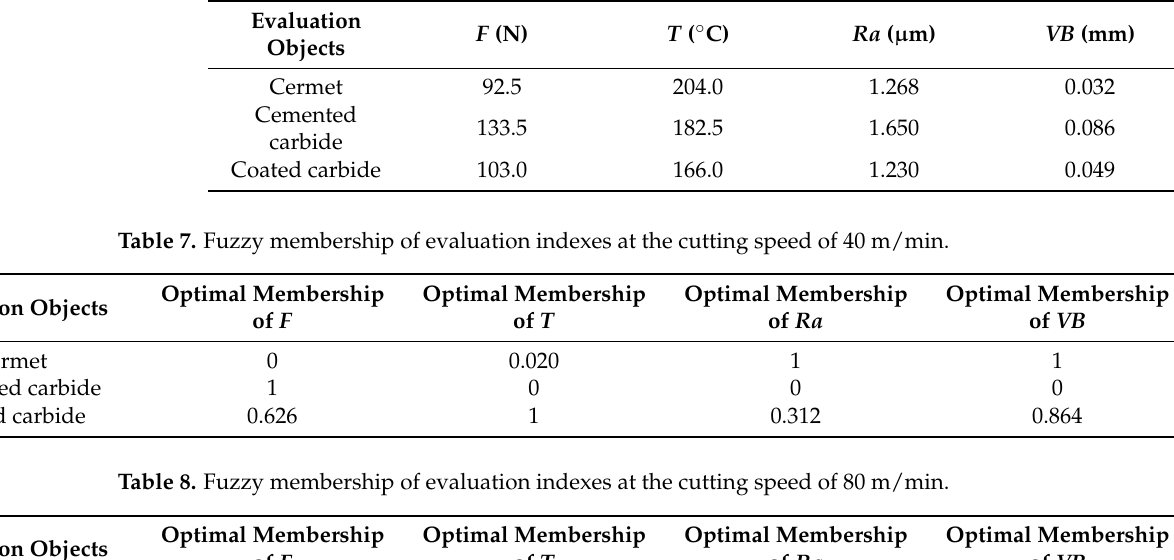
Table 6. Mean values of evaluation indexes at the cutting speed of 80 m/min.